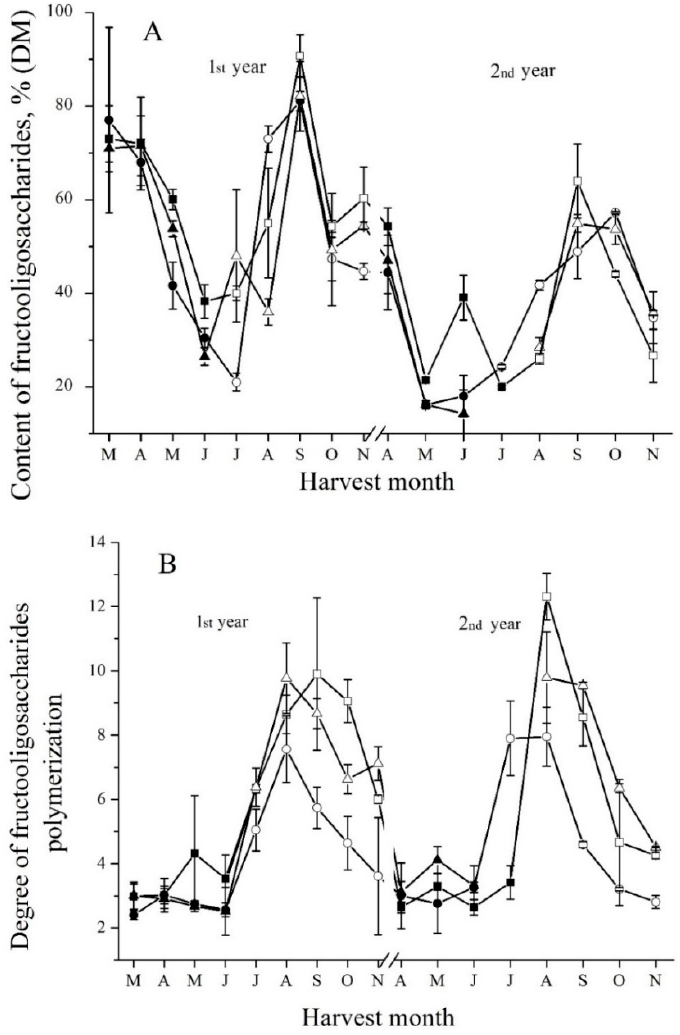
Figure 2. Seasonal fluctuations of fructooligosaccharides content ( A ) and degree of polymerization ( B ) in the tubers of Sauliai ( ● , ○ ), Albik ( ▲ , ∆ ), and Rubik ( ■ , □ ); spring tubers: ● , ▲ , ■ ; summer and autumn tubers: ○ , ∆ , □ .